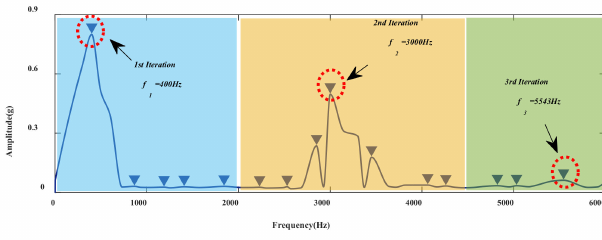
Figure 9. Adjustment